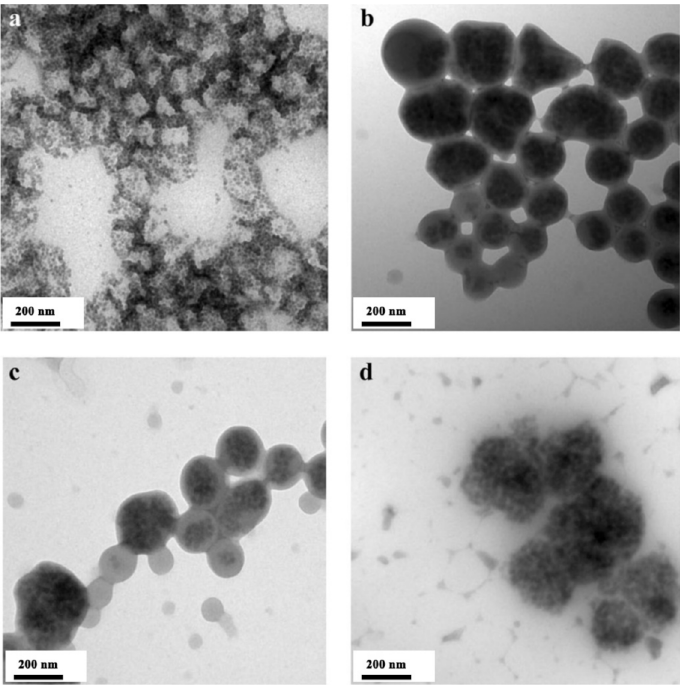
Figure 2. TEM images of poly(MMA–co–BA)@SiO 2 nanocomposite particles prepared by in situ emulsion polymerization (the surface MPS coupling densities of SiO 2 nanoparticles are as follows: ( a ), 1.44 µ mol · (m 2 SiO 2 ) − 1 ; ( b ), 2.24 µ mol · (m 2 SiO 2 ) − 1 ; ( c ), 2.97 µ mol · (m 2 SiO 2 ) − 1 ; ( d ), 3.52 µ mol · (m 2 SiO 2 ) − 1 ). Reproduced from [30] with permission from Springer